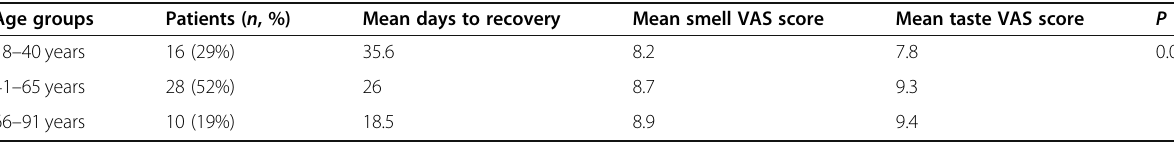
Table 4 The mean time to recovery according to age groups Age